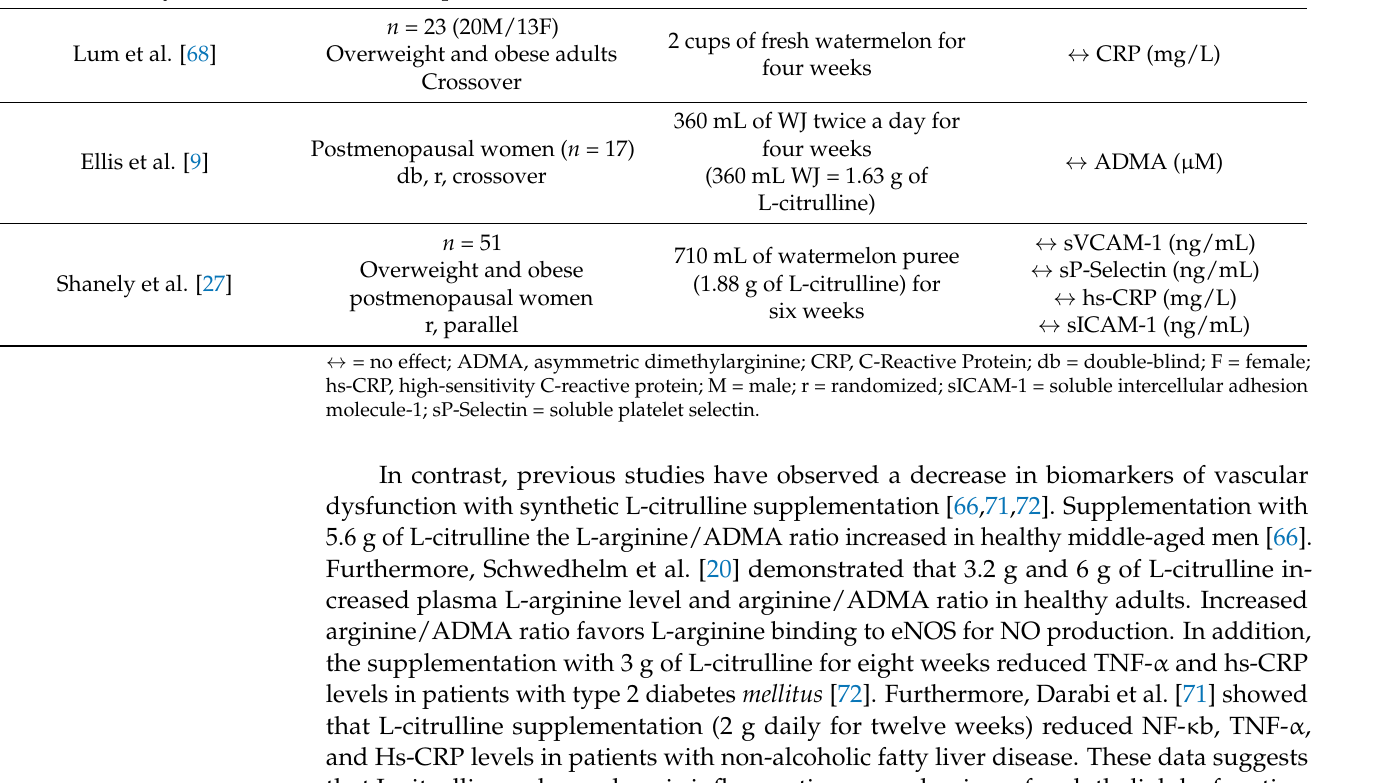
Table 4. Summary of the studies that evaluated the effect of watermelon ingestion on plasma biomarkers. Study